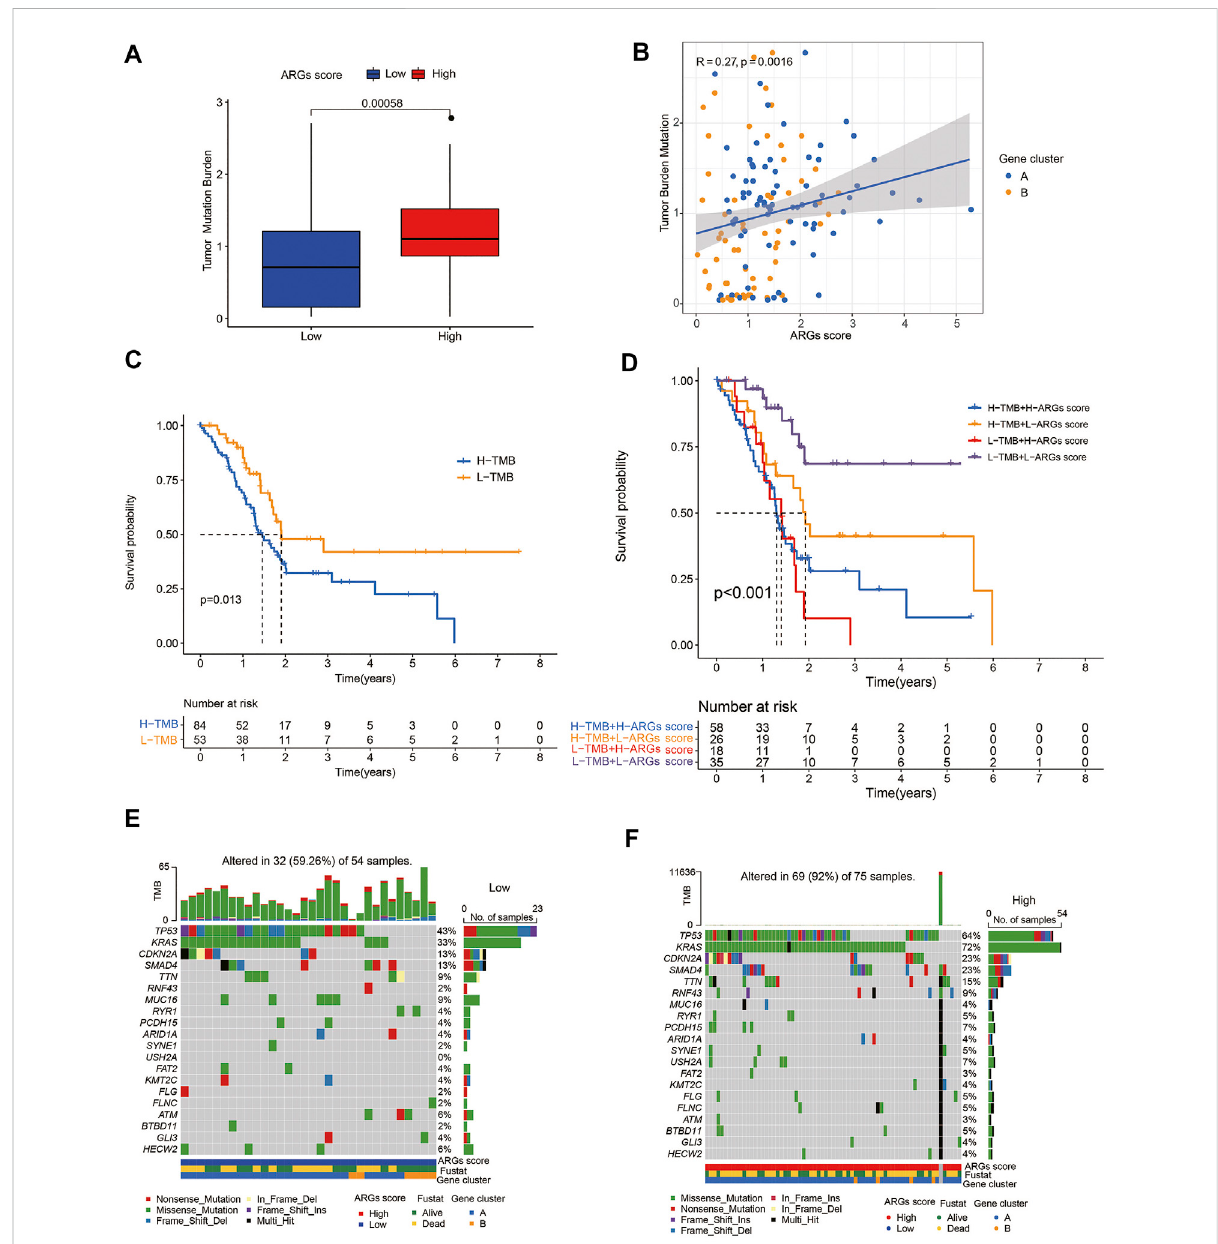
FIGURE 7 Association of ARGs score with TMB score in PC: (A) TMB in different ARGs score groups; (B) Spearman correlation analysis of the ARGs score and TMB; (C) Kaplan-Meier analysis of the OS between the low- and high-TMB groups; (D) Survival analysis among four patient groups strati fi ed by both TMB and ARGs score; (E,F) The waterfall plot of somatic mutation features established with low and high ARGs